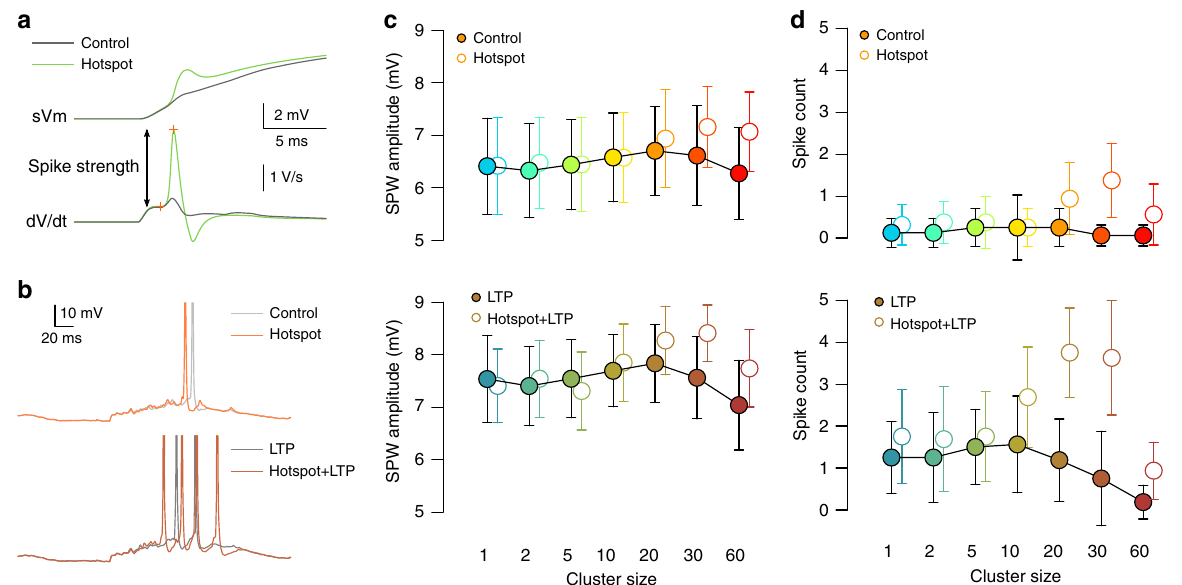
Fig. 5 The effect of strong dendritic branches on clustering based tuning during SPW activity. Source data are provided as a Source Data fi le. a Somatic membrane potential (top) and its time derivative (bottom) in response to the activation of 30 synapses in control condition (grey) and with a Na + hotspot in the middle of the stimulated branch (green). b Example responses in control conditions (grey) and with strong dendritic branches (coloured) without (top) and with LTP (bottom) in the case of 10 synapse per cluster when the replayed trajectory maximally overlapped with the place fi elds of the clustered synapses (trajectory start = 80 cm). Action potentials were truncated. c Average somatic Vm depolarisation amplitude during the SPW in control conditions ( fi lled circles) and with strong dendritic branches (empty symbols) as a function of cluster size without (top) and with LTP (bottom) with trajectory start = 80 cm. The presence of strong branches increases the depolarisation and the spike count when the synaptic clusters are large. Symbols show mean and SD of 16 simulations with different inputs but identical cluster arrangements. d Similar to c , but the average spike count during the SPW is